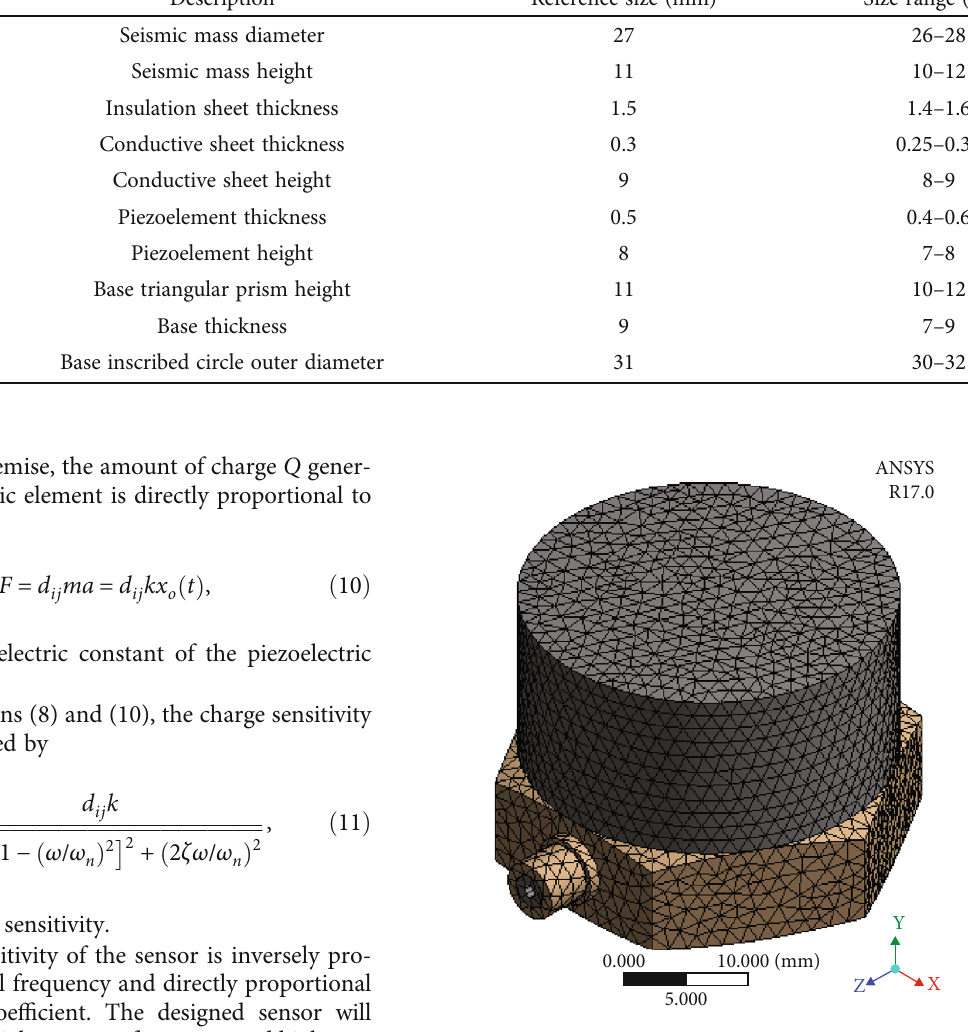
Figure 5: Finite element model of the designed sensor.